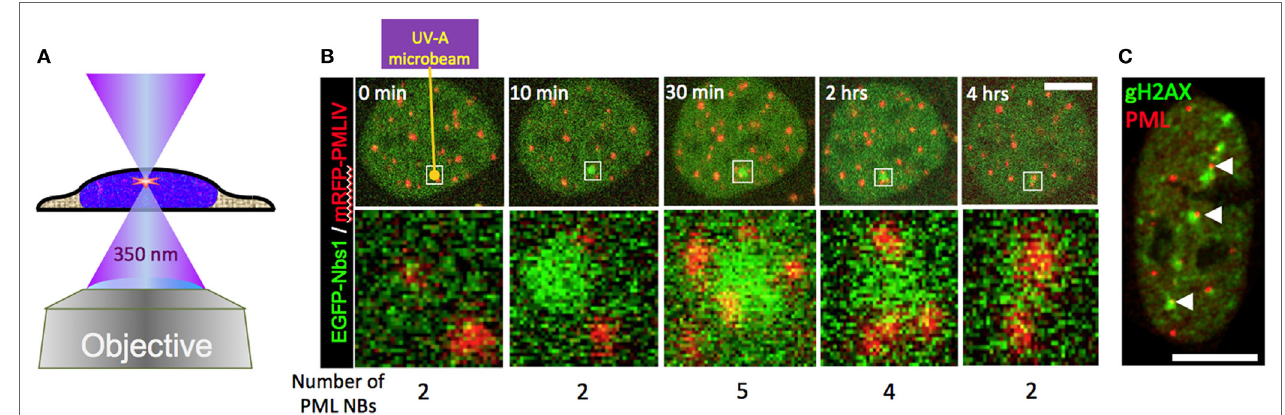
FigURe 8 | Behavior of promyelocytic leukemia (PML) bodies at UV-A microbeam induced DNA damage foci. (A) For laser damage induction, a pulsed 350 nm Nd:YLF (neodymium-doped yttrium lithium fluoride) UV-A laser (Spectra Physics) was coupled into a confocal laser scanning microscope (LSM 510) via the epifluorescence illumination path. The laser-microbeam is focused into the middle of the field of view by a 100 × , NA 1.3 Plan Neofluar oil immersion objective (Zeiss). The Nd:YLF laser can be frequency-tripled delivering 20 ns duration pulses at 350 nm with user-defined energies from 1 µJ to 200 µJ at user defined repetition rates 1–1000 Hz. (B) A living U2OS cell expressing EGFP-tagged NBS1 and mRFP-tagged PML-IV was irradiated at a single defined spot with approx. 5 µJ of energy using the set-up described above (yellow arrow). Confocal stacks were acquired across the nucleus before and at indicated time points after the damage pulse. In (C) , U2OS cells were microirradiated at multiple positions with high laser power (40 µJ per site). Twenty-four hours after DNA damage induction cells were fixed and stained to detect the DNA damage marker gH2AX (green) and endogenous PML (red). Scale bars, 5